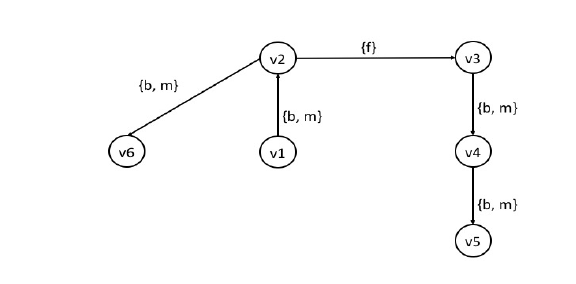
Figure 10. QCN when temporal entities are